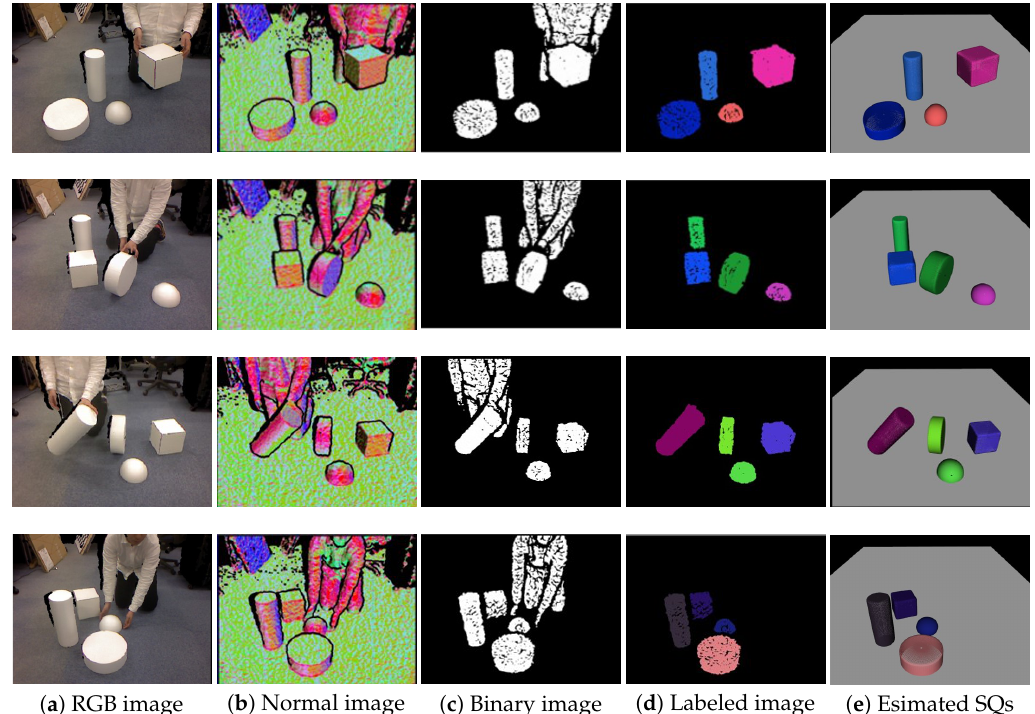
Figure 6. Output images of the each processing step at different scenes. ( a ) RGB image of the captured scene, ( b ) normal map, ( c ) geometric segmentation result, ( d ) labeling result, and ( e ) superquadric and pose parameter estimation result. Superquadric surfaces were rendered onto 2D